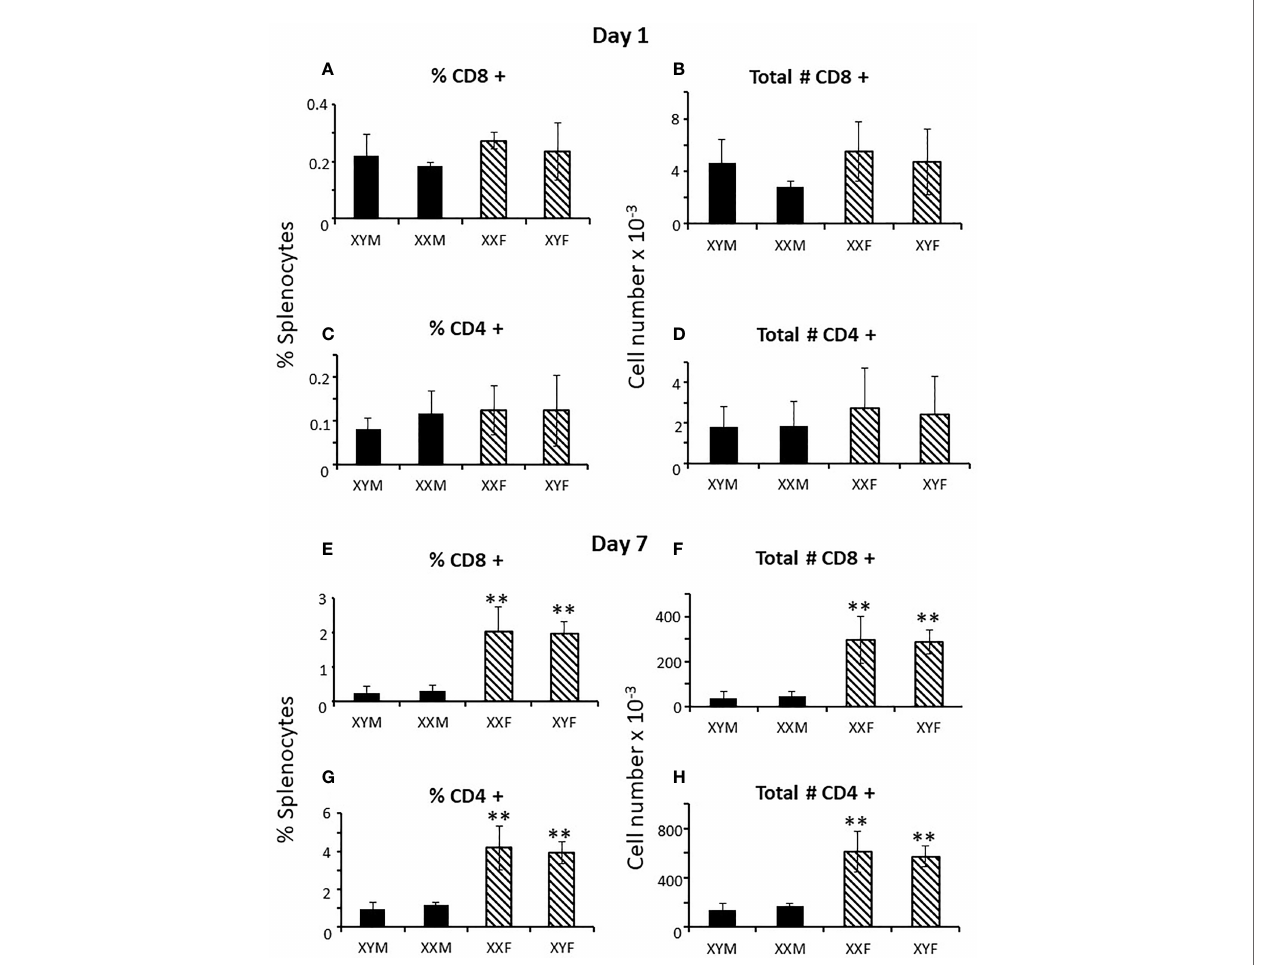
FIGURE 3 | Mature T cell content (percentages and numbers) of the spleens of pups at 1 and 7 days of age. Data are presented as a percentage of gated lymphocytes. The means ± SD are derived from 17 XYM, 14 XXM, 15XXF, and 16 XYF animals at day 1, and 13 XYM, 14 XXM, 22 XXF, and 13 XYF animals at day 7. **, different from both male genotypes, p <